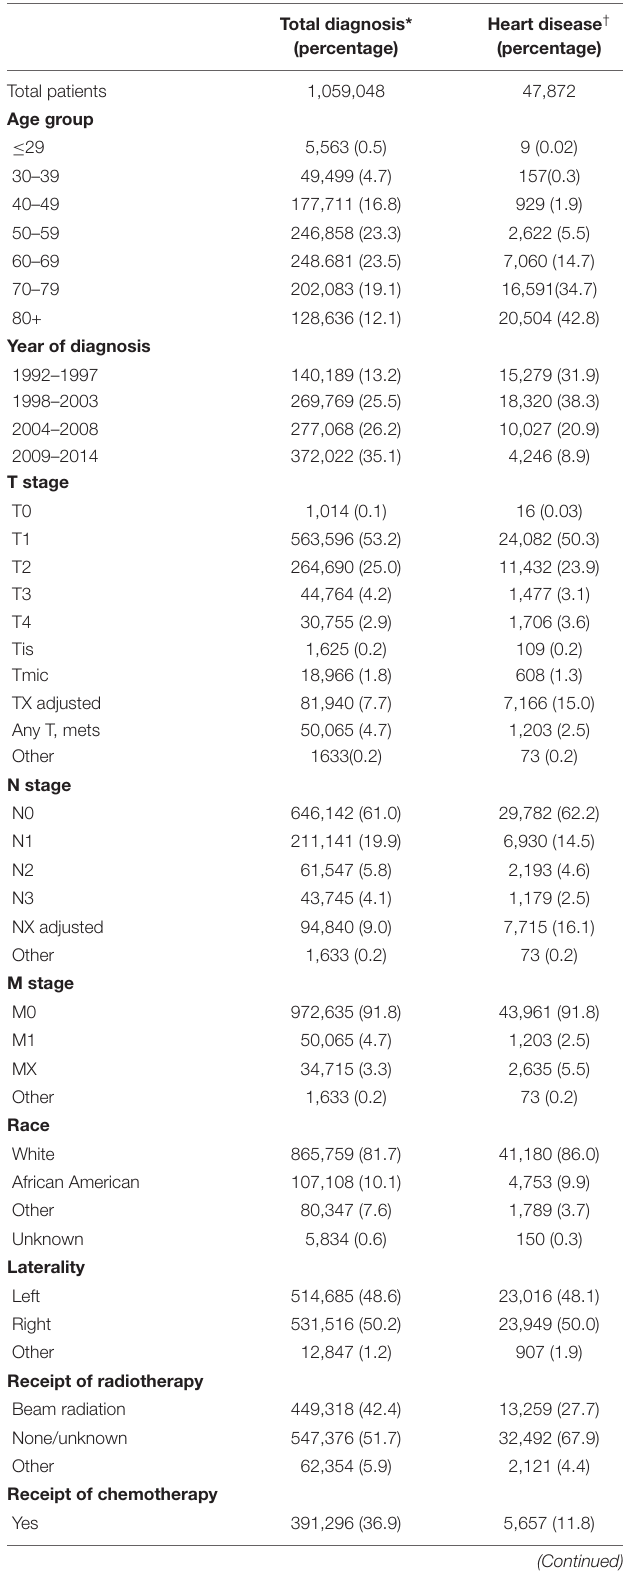
TABLE 1 | Demographics for patients diagnosed with breast cancer from 1992 to 2014 and for patients who died from heart